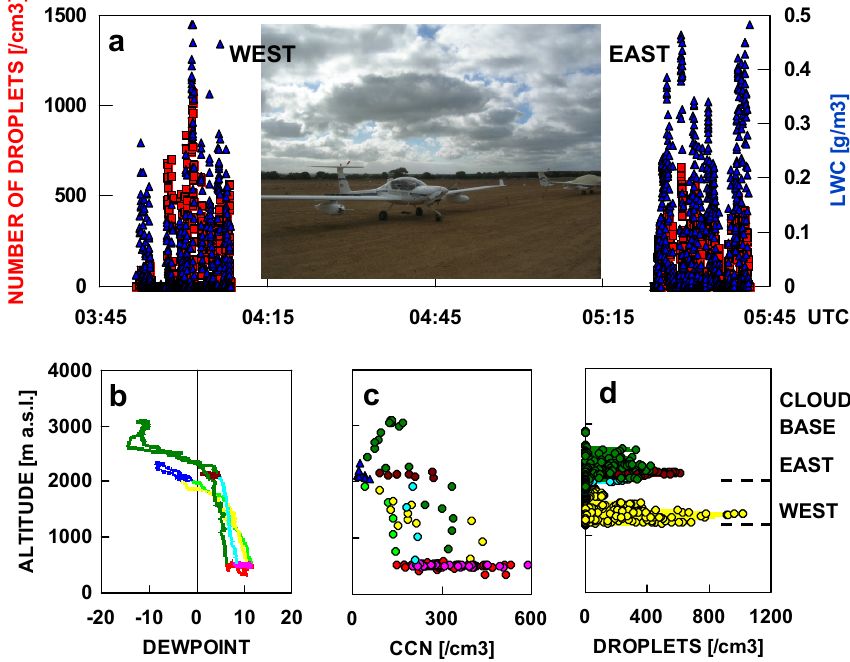
Fig. 5. Cloud day (21 August 2007, winter). Upper panel: red squares: number of droplets/cm 3 , blue triangles: liquid water content. The left group of data was measured in the west (agriculture), the right in the east (natural vegetation). Lower panel: dewpoint, cloud condensation nuclei and cloud droplets are shown in the bottom panels (b,c,d) from ascents/descents on both sides of the Fence. The difference between the green (11:00 LT) and yellow profiles (12:00 LT) shows the rapid growth of nucleation mode particles into the CCN range. The different condensation levels are a result of the lower temperatures and higher water vapour content in the west. The light blue (13:15 LT), brown and dark green (14:00 LT) data are from the natural vegetation side. Times are given in local time (LT) ± 10min for each profile. Note the differences in dewpoint and cloud base.